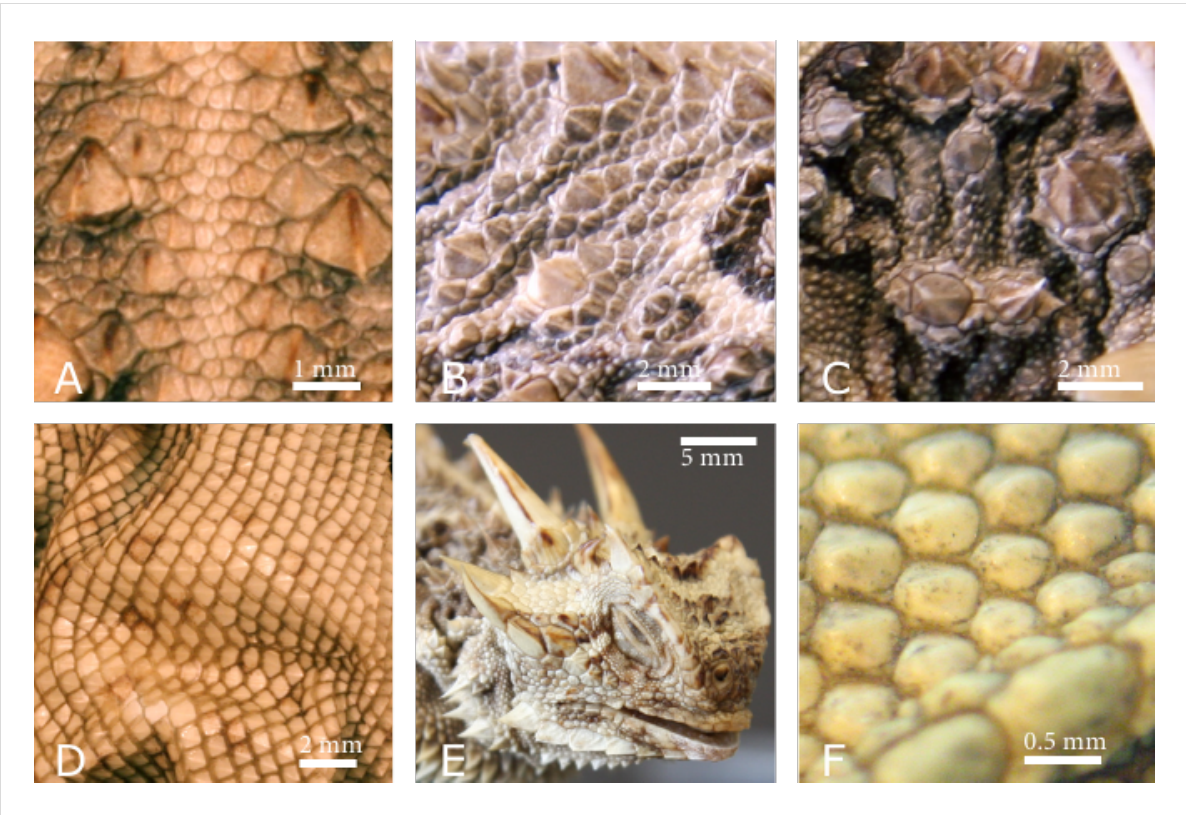
Figure 2: Different sizes and morphologies of scales of Phrynosoma cornutum . (A) Dorsal (back) scales along the medial line. (B) The lateral back is characterised by thorn like scales surrounded by small polygonal scales. (C) In the lateral neck region the thorns are mainly circular and are surrounded by small circular scales. (D) Ventral scales are diamond shaped and rather regular. (E) The scales on the head exhibit an enormous variety with respect to the morphology and size. (F) The scales on the chin are regular and almost circular.